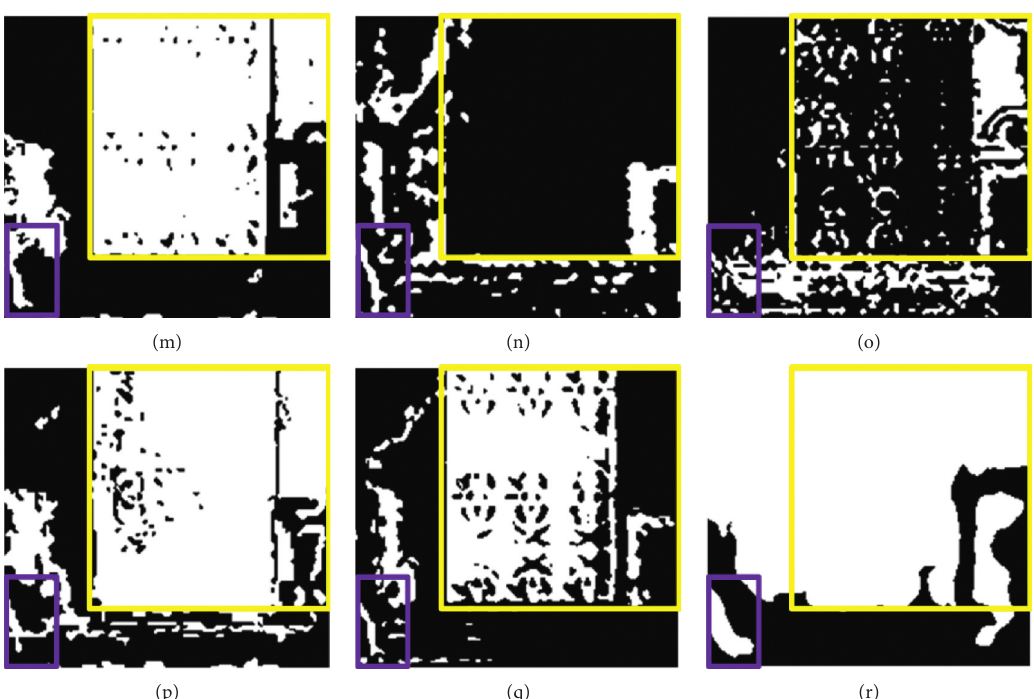
Figure 6: CD maps of patches I1 and I2: (a-b) patch I1; (c) reference map of Patch I1; (d–i) CD maps obtained in patch I1 using the proposed method and Methods 1, 2, 3, 4, and 5, respectively; (j-k) patch I2; (l) reference map of patch I2; (m–r) CD maps obtained in patch I2 using the proposed method and Methods 1, 2, 3, 4, and 5,